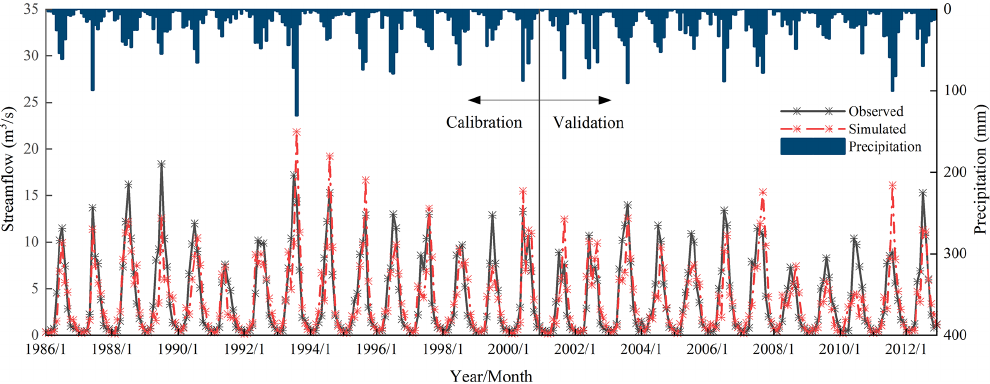
Figure 2. Simulated and observed monthly streamflow series relative to precipitation ( P ) during the calibration and validation periods in the JRB.